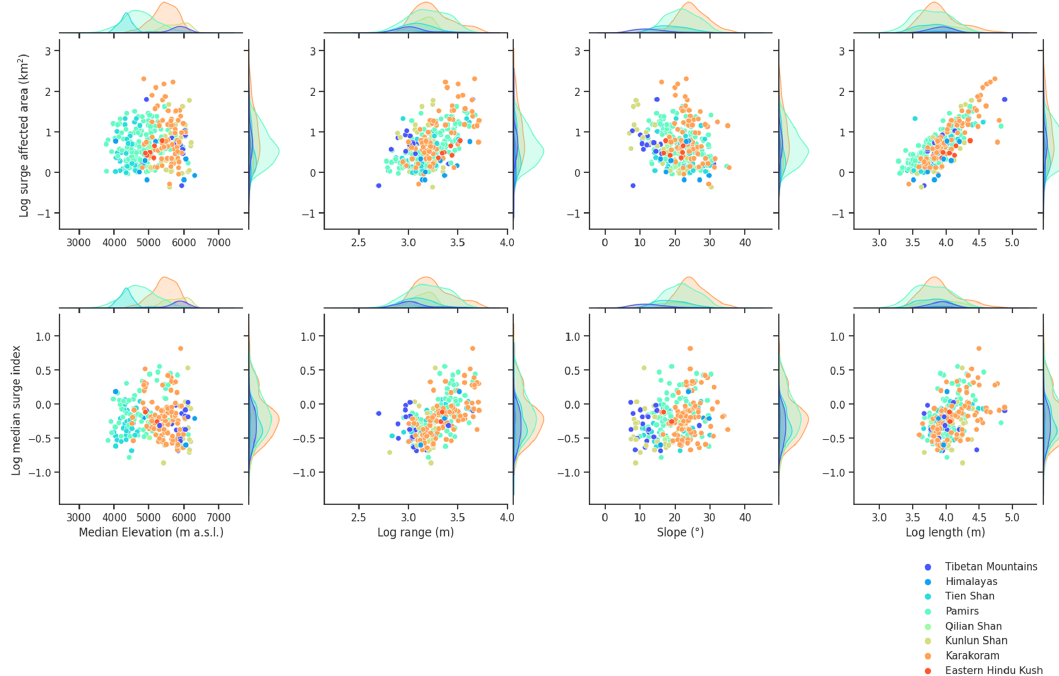
Figure 9. Correlation between the different geometric parameters of surge-type glaciers. Table 2. Example of mass balance (m.w.e.a − 1 ) over a specified period and phases in the surge cycles of Khurdopin and Hispar glaciers’ last documented surges. Data from Hugonnet et al. (2021). Note the substantial uncertainties associated with each elevation change estimate. For